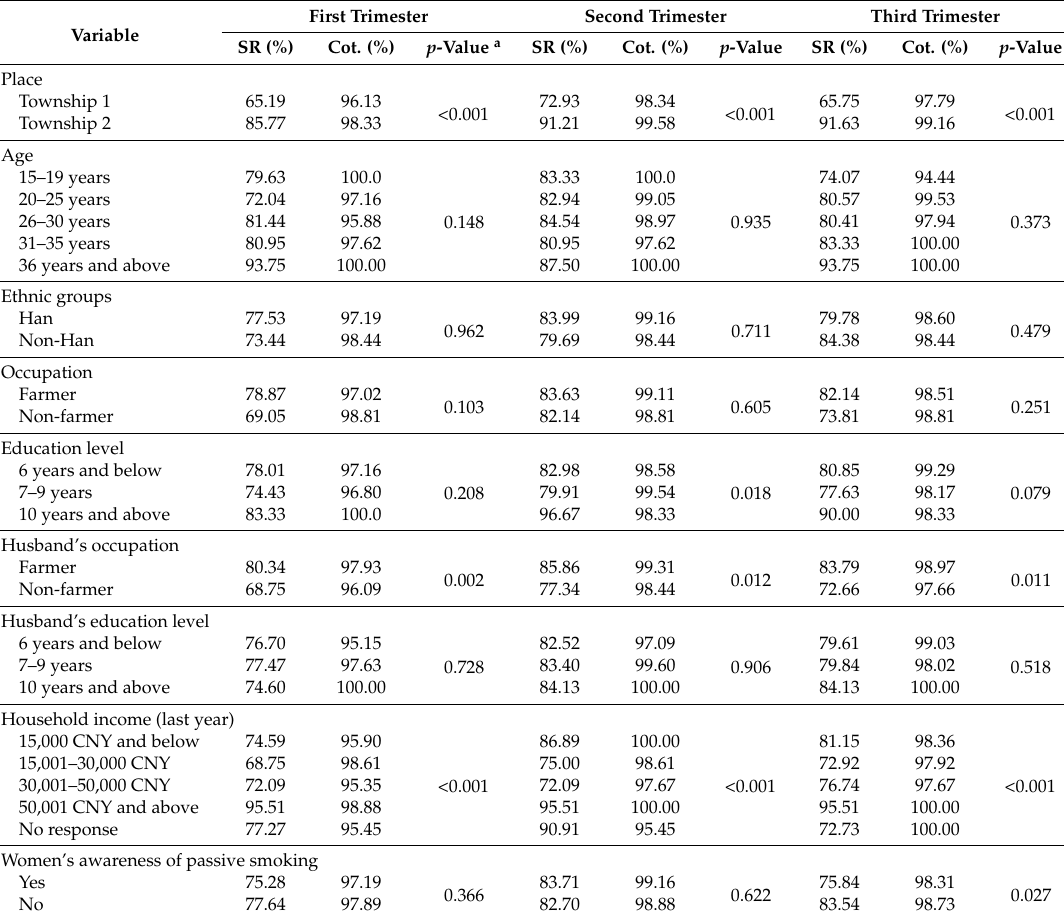
Table 2. Differences in study variables between self-reported (SR) and urinary cotinine (UC)-verified ETS exposure (in